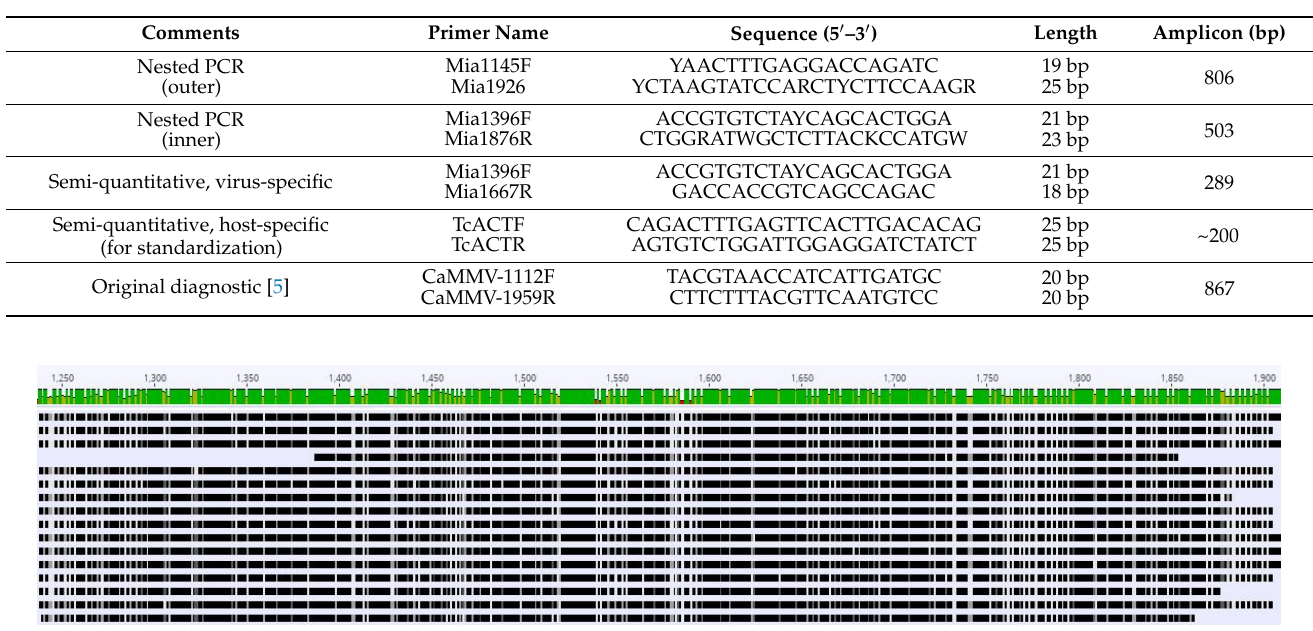
Table 1. Primer pairs used for CaMMV detection and localization in this study.